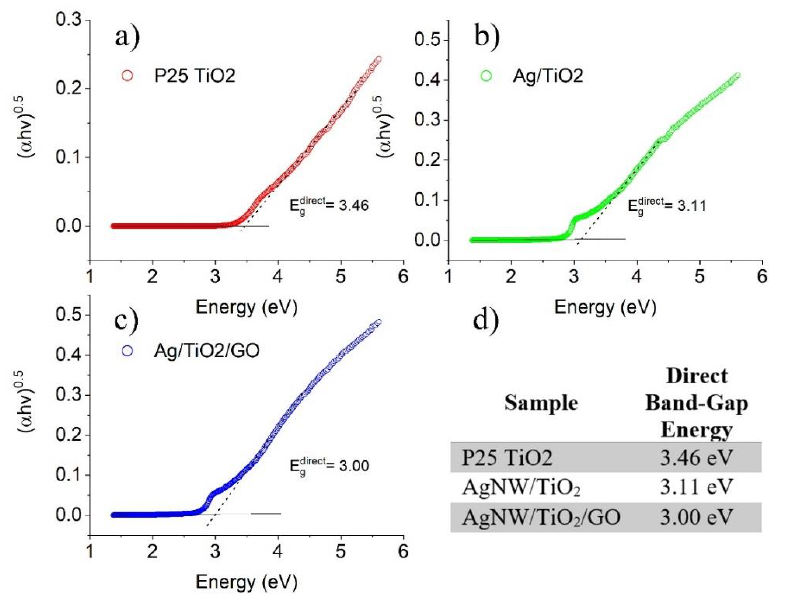
Figure 6. Tauc plot of the modified Kubelka–Munk (KM) function of ( a ) P25 TiO 2 , ( b ) AgNW/TiO 2 , ( c ) AgNW/TiO 2 /GO, and ( d ) calculated direct band gaps of each sample.